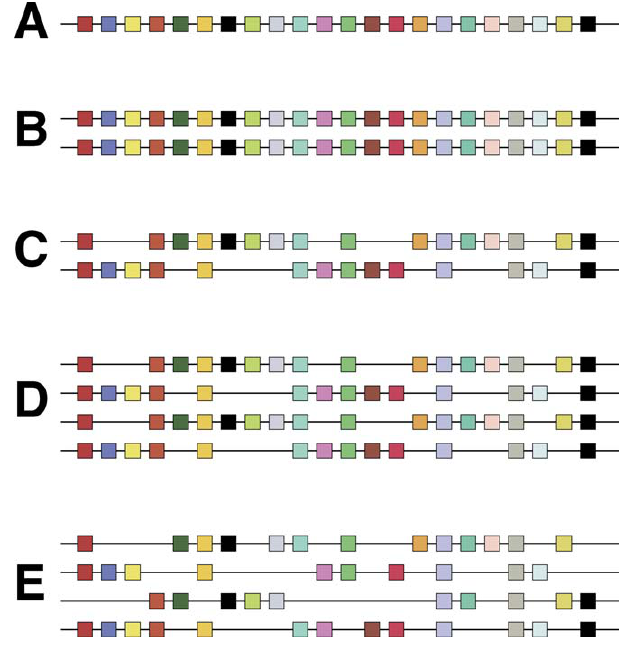
Figure 1. Pattern Predicted for the Relative Locations of Paralogous Genes from Two Genome